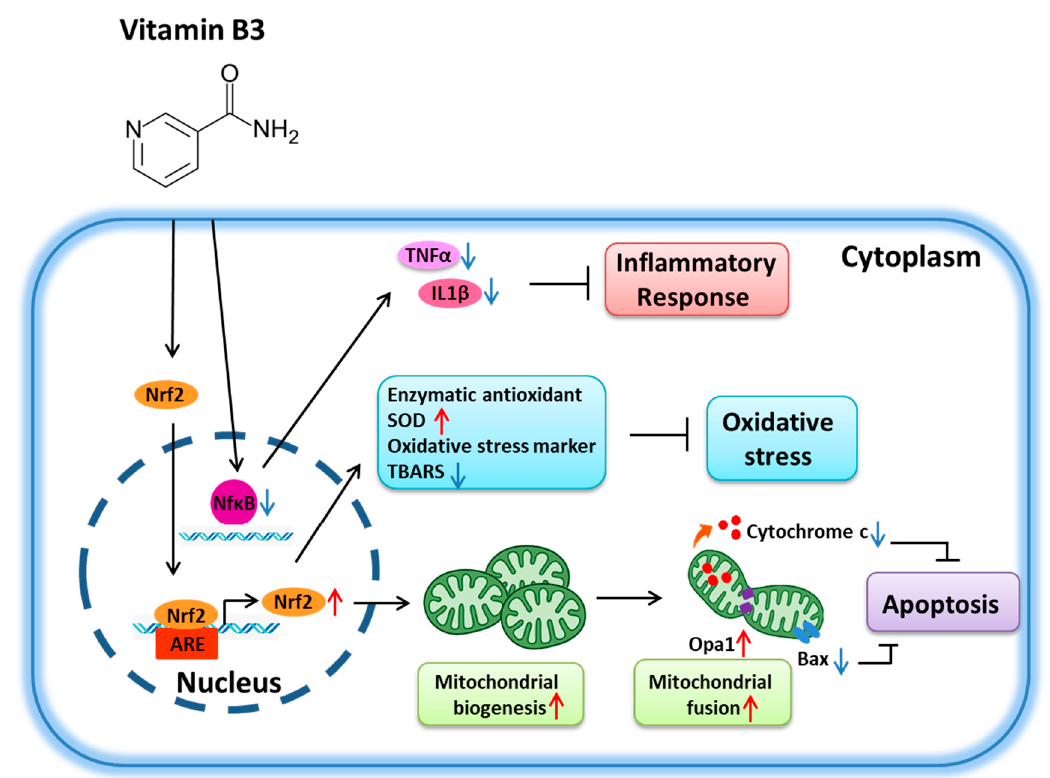
Figure 7. Summary of the neuroprotective effects of vitamin B3 in the rAION. Vitamin B3 treatment provided better anti-inflammatory, antioxidative, and antiapoptotic effects than PBS treatment.